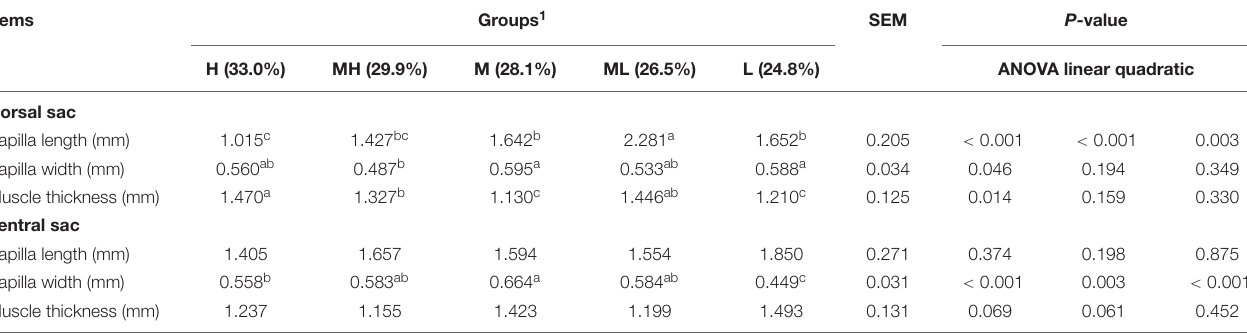
TABLE 3 | Effects of dietary peNDF level on the morphology of goat rumen.